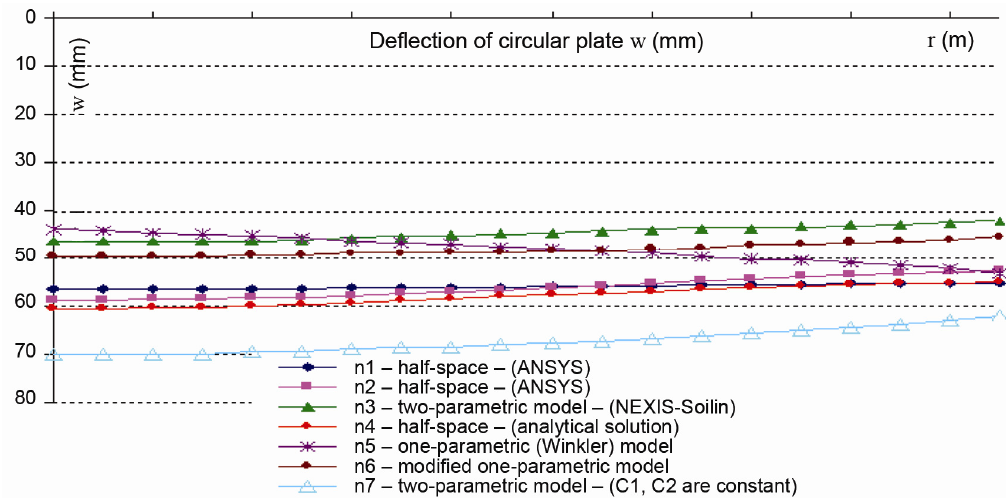
Fig. 4. Vertical deformation of the circular